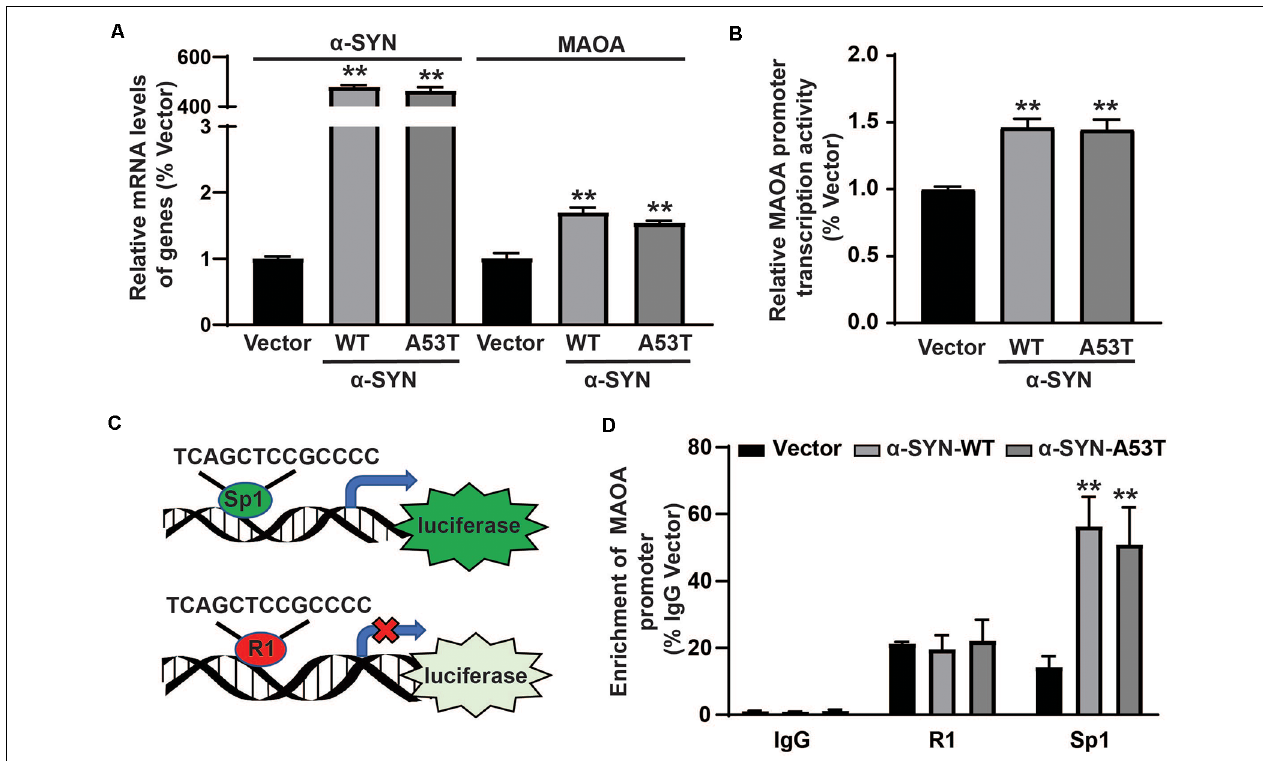
FIGURE 4 | α -SYN affected the protein synthesis of MAOA. The mRNA level of MAOA (A) and the activity of MAOA promoter luciferase (B) were analyzed in control cells (Vector), α -SYN WT and α -SYN A53T stably overexpressed cells. The transcription factor diagram of bioinformatics analysis MAOA promoter luciferase plasmid (C) . ChIP-Real-time PCR analyzed the binding quantity of R1 and Sp1 with the MAOA promoter region (D) . Data were expressed as mean ± SEM. ** p < 0.01 vs. Vector transfected cells, n =